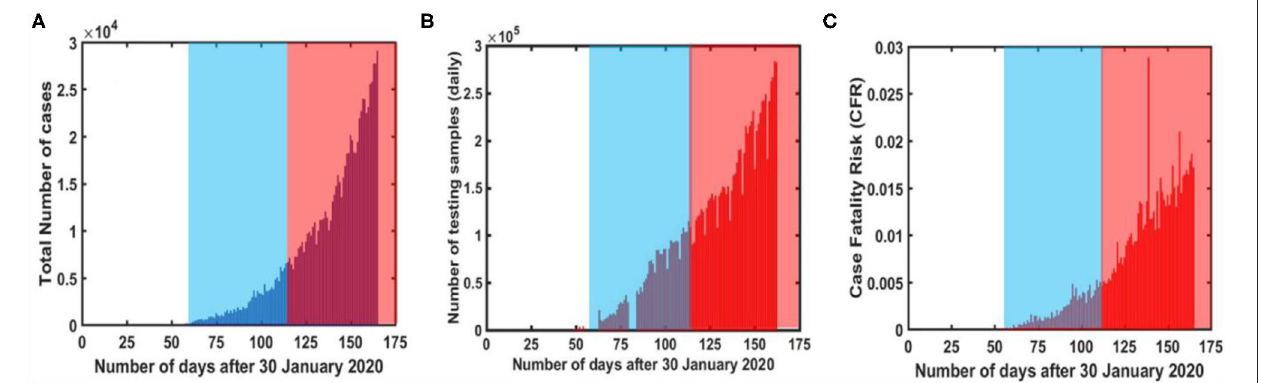
FIGURE 4 | COVID-19 reported data [5] based analysis during different time intervals in India (A) Reported number of daily cases (B) daily tested samples (C) Case Fatality Ratio (CFR). The time interval has been divided into three sections i.e., pre-lockdown, during lockdown (blue shaded area) and post-lockdown (red shaded area), respectively.